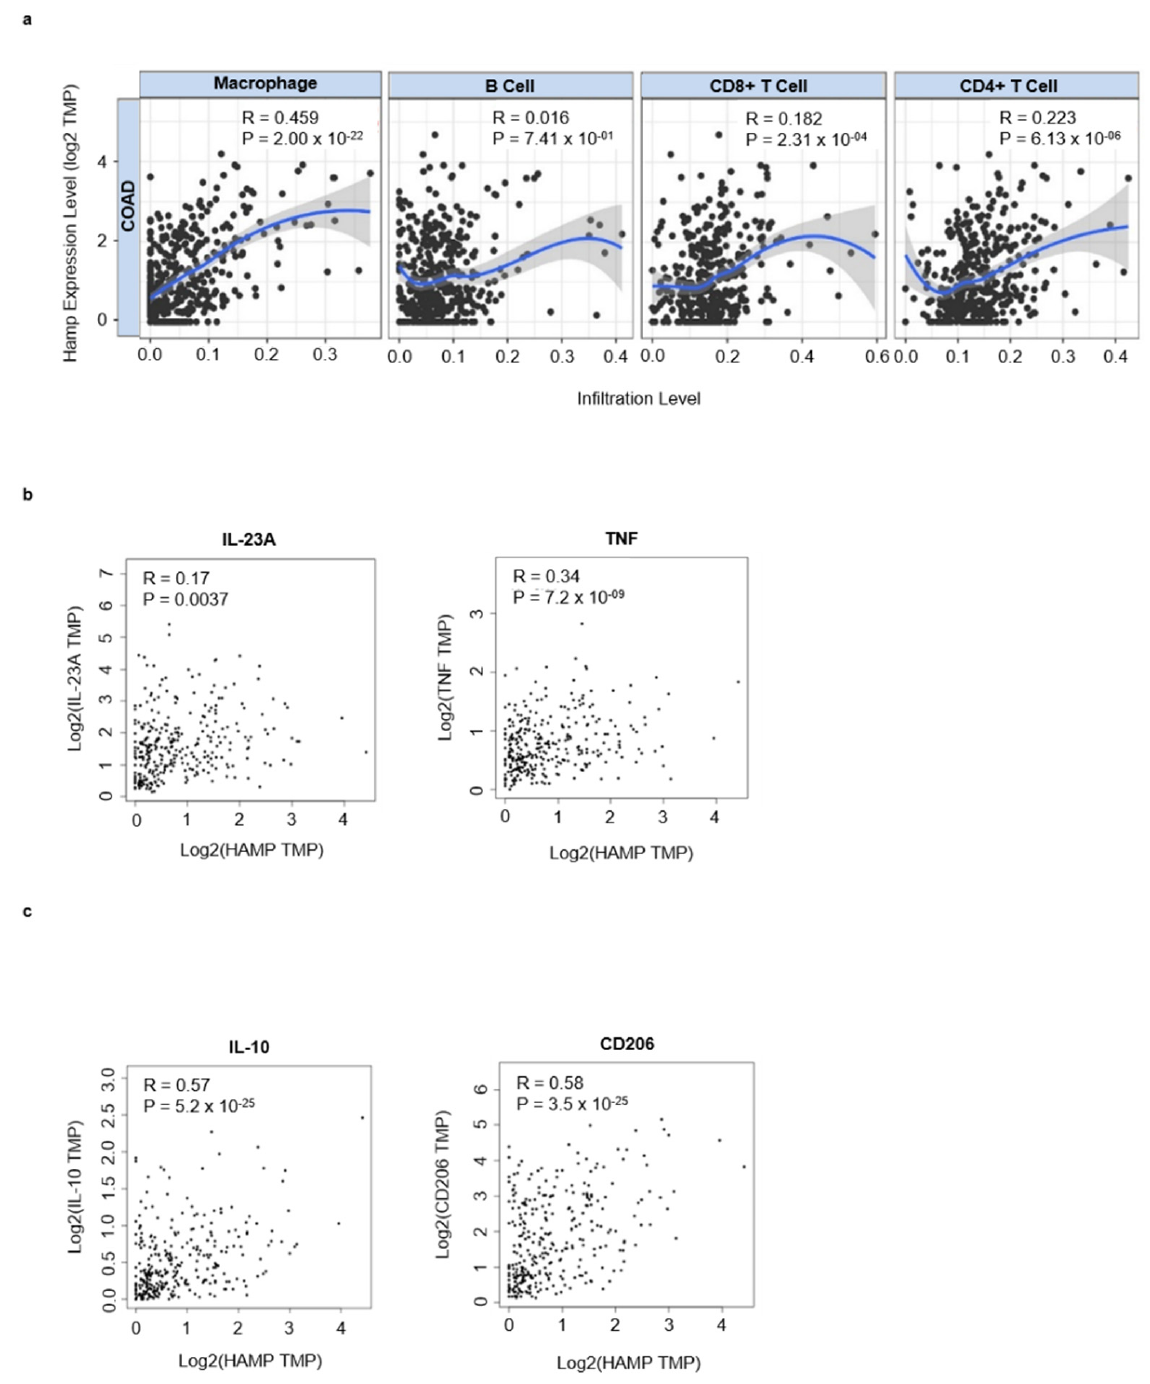
Figure 4. Hepcidin correlates with infiltrating immune cells and macrophages markers in CRC. ( a ) Scatterplots of the correlations between hepcidin expression and the infiltration of different immune cells using the TIMER database. ( b , c ) Correlation between hepcidin expression and either IL-23A and TNF, 2 markers of inflammatory macrophages, or IL-10 and CD206, two markers of regulatory macrophages.